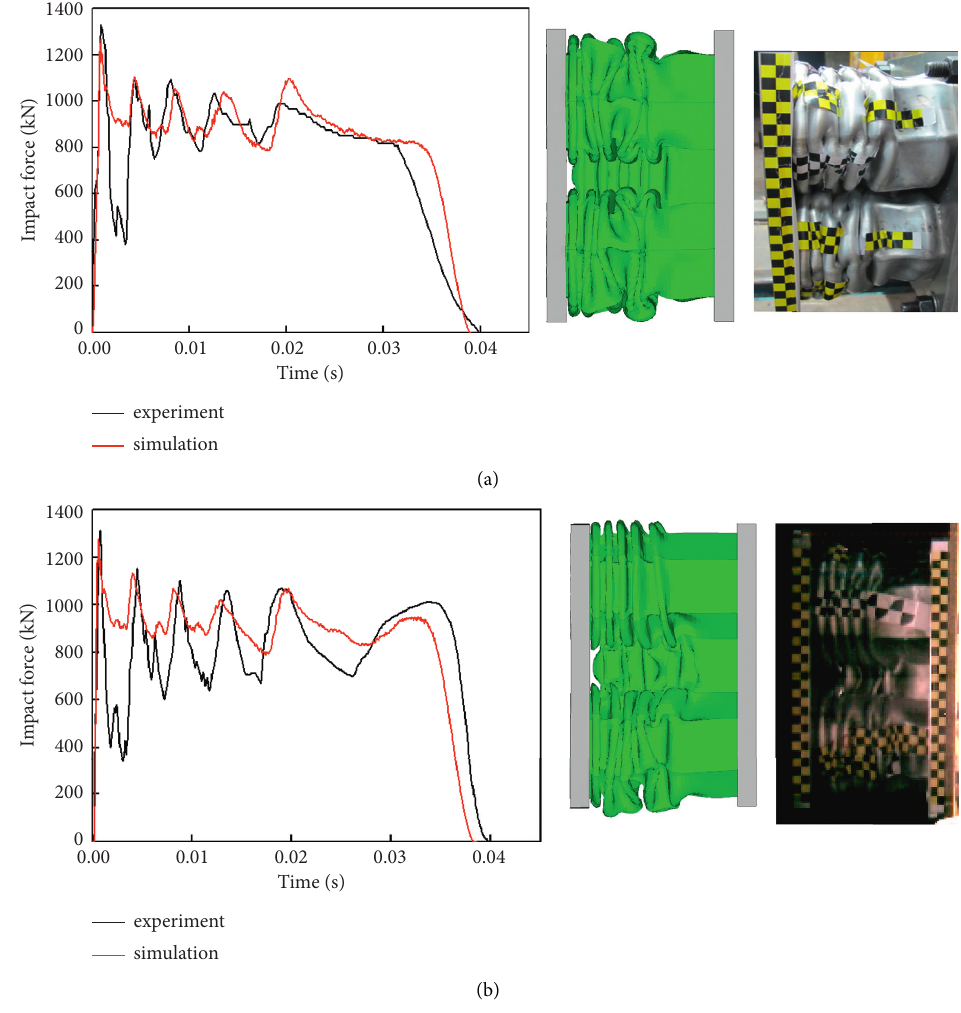
Figure 6: Comparison of experimental and simulation results. (a)Sample 1. (b)Sample 2. Table 1: Comparison of key parameters between test and